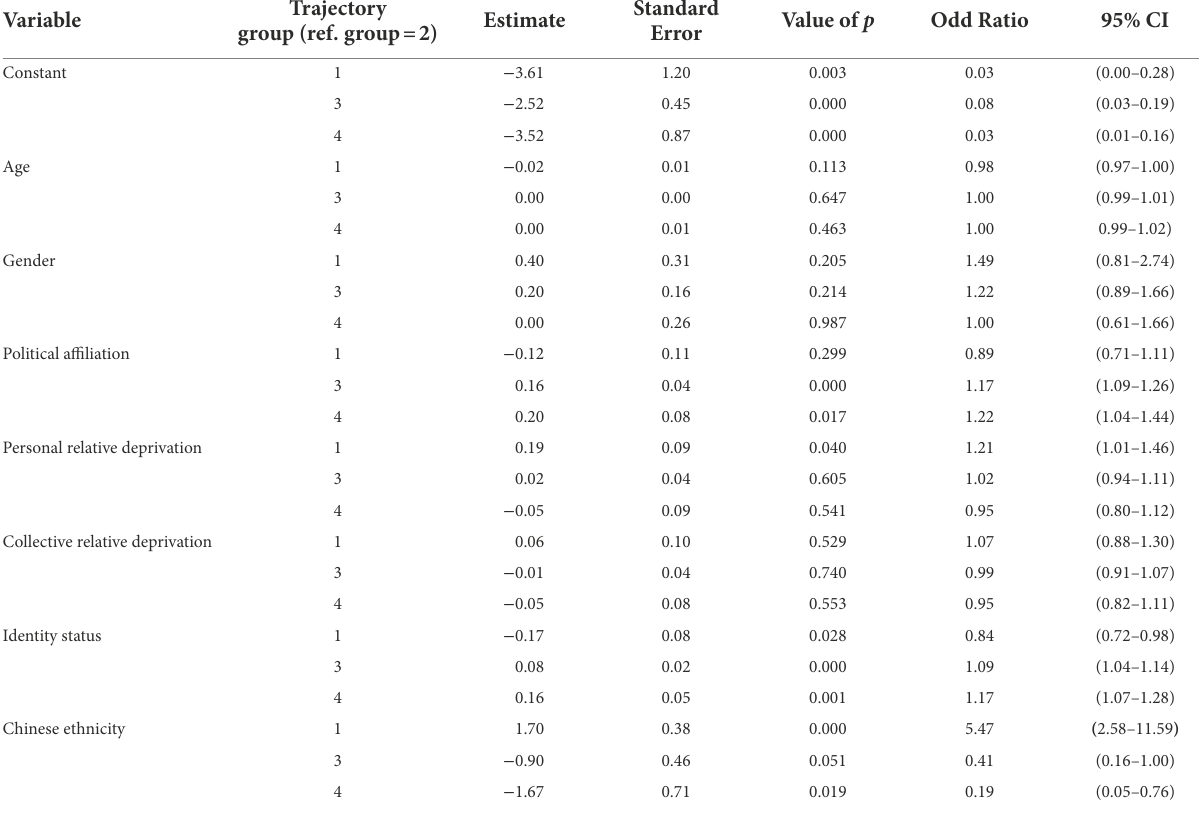
TABLE 8 Antecedents of trajectory group membership of prejudice with the control variable.